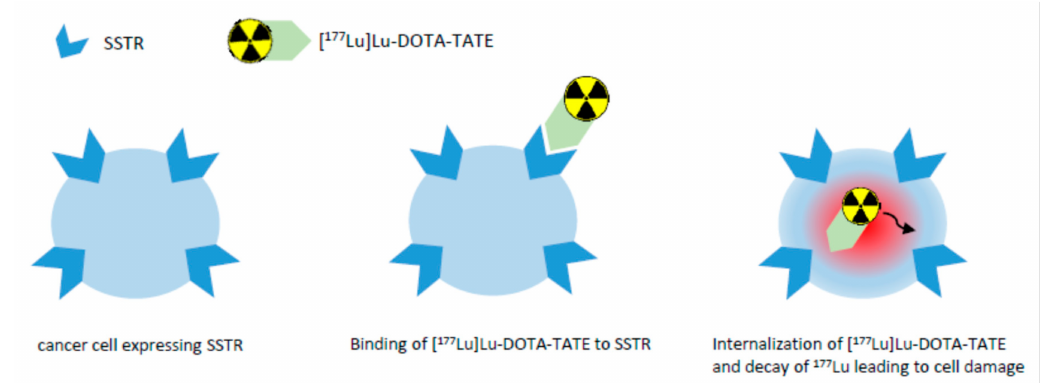
Figure 2. Simplified overview on the mechanism of action of [ 177